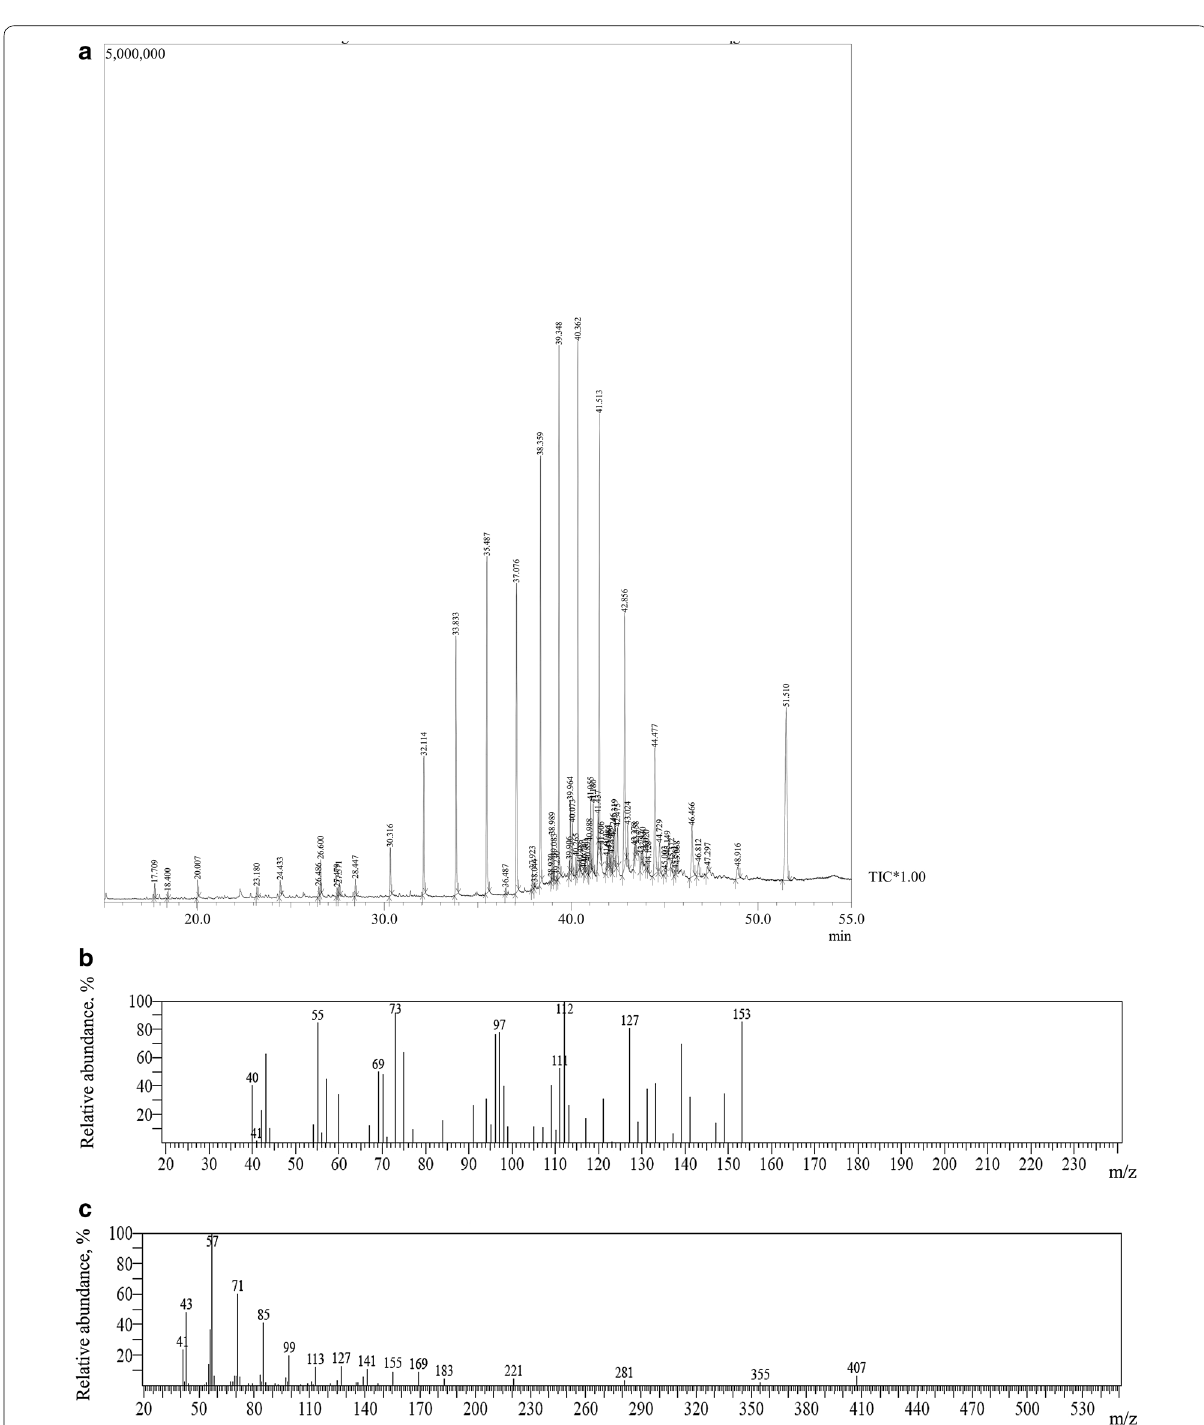
Fig. 6 a Chromatogram analysis of metabolites produced during degradation of APAP by GC–MS; b mass peak of 2-isopropyl-5-methylcyclohexan one.; c mass peak of